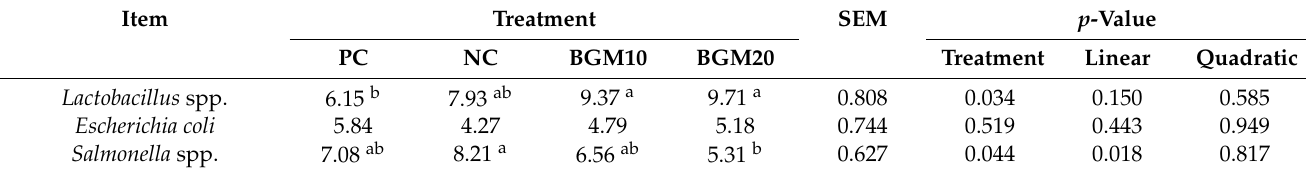
Table 8. Effect of dietary BGM with multienzyme addition on microbial counts (log 10 CFU/g) in weaning pigs 1,2